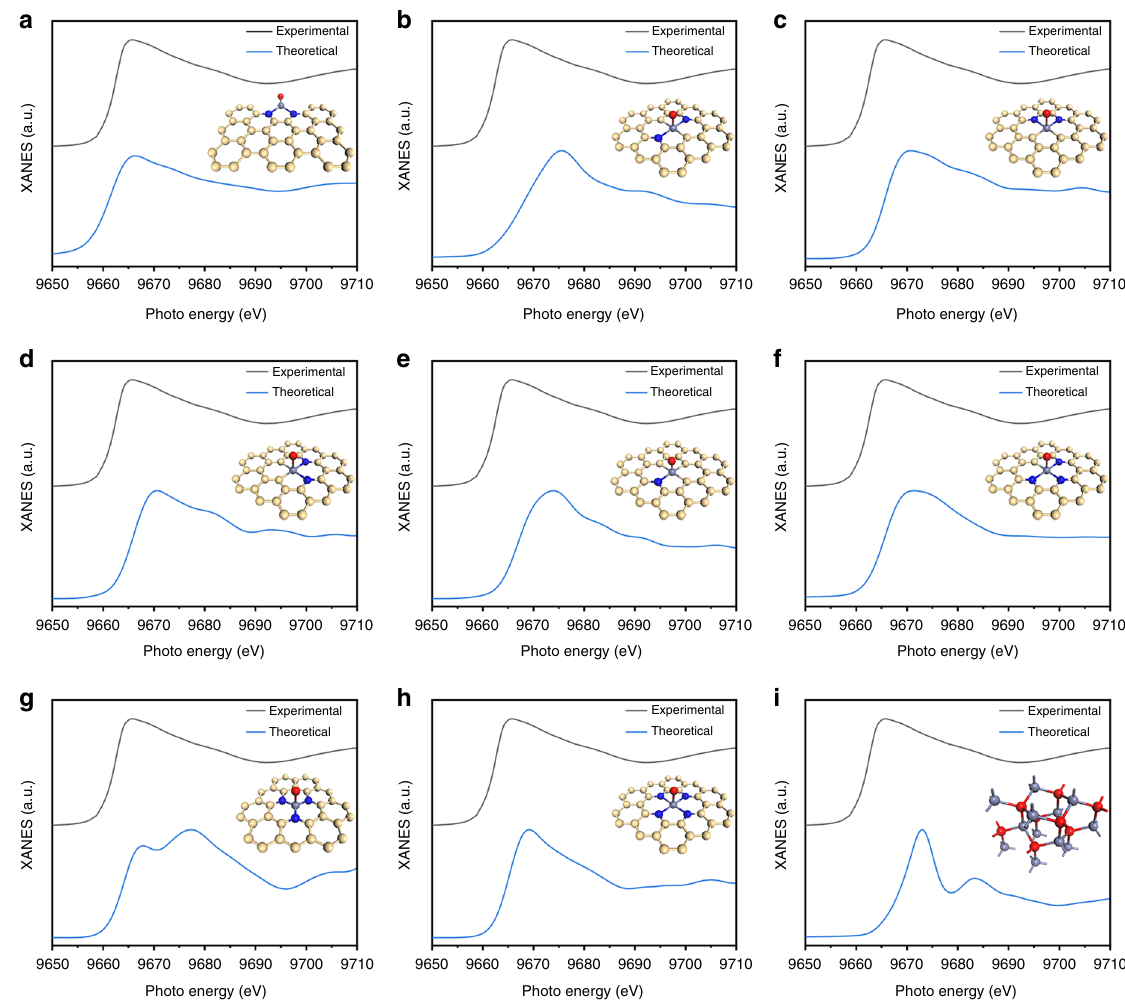
Fig. 3 Theoretical calculation of X-ray absorption near edge structure (XANES) spectra. a – i Comparison of Zn K -edge XANES spectra of ZnNC and theoretical XANES spectra calculated with different active site structures. Insets are corresponding schematic models of the active site structures. Light yellow, blue, light purple and red ivory balls represent carbon, nitrogen, zinc and oxygen atoms,